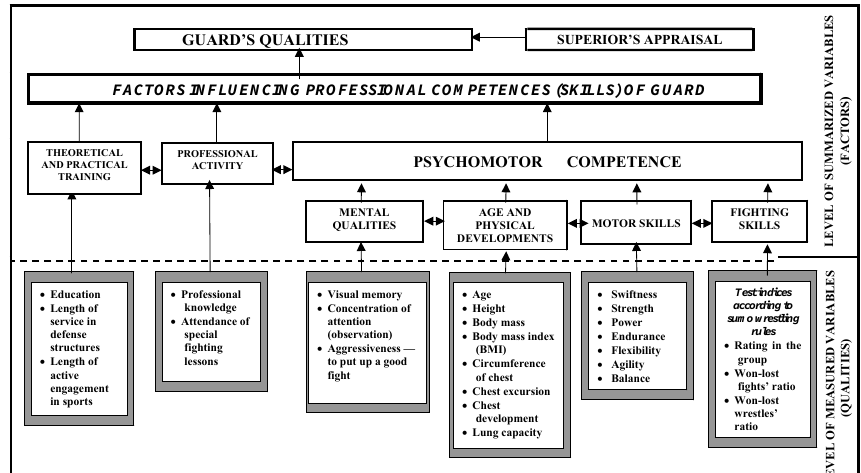
Fig. 1. Factors predetermining pro- fessional in